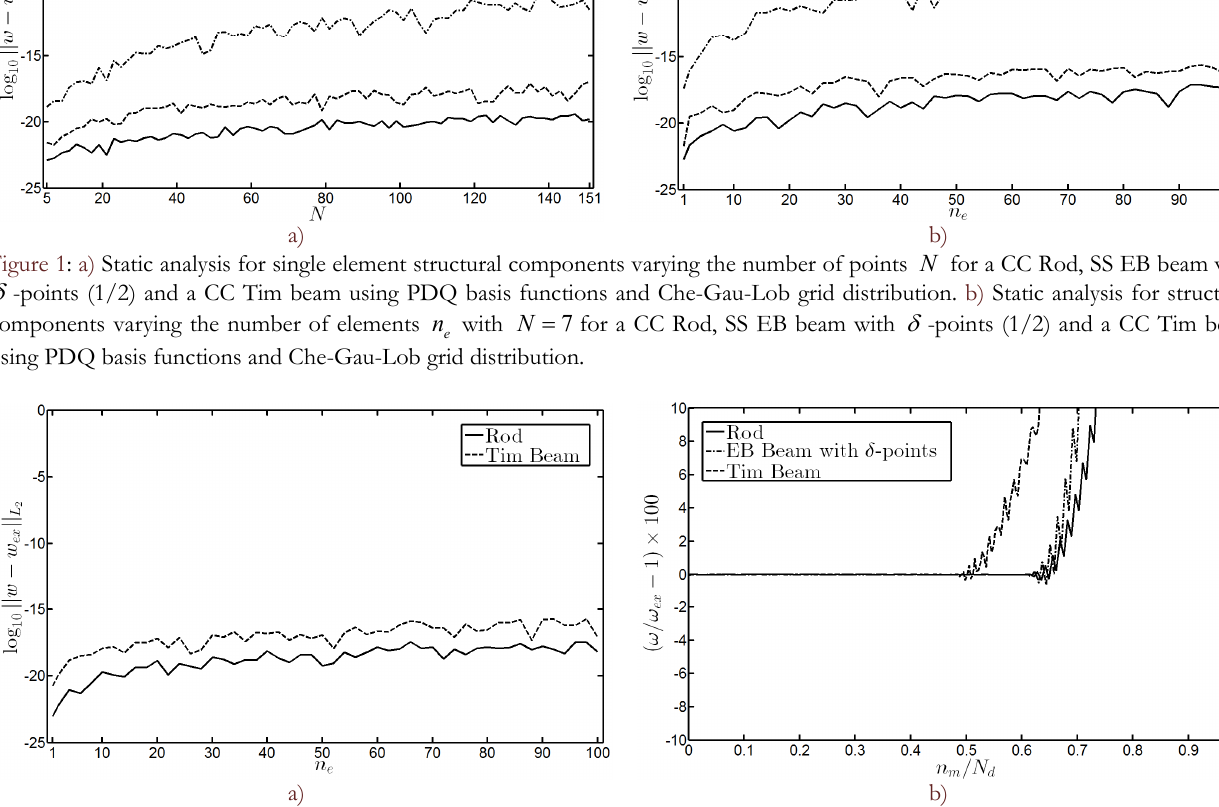
Figure 2: a) Static analysis for structural components using Weak Formulation (WFEM) varying the number of elements 7 N  for a CC Rod and a CC Tim beam using PDQ basis functions and Leg-Gau-Lob grid distribution. b) Dynamic discrete spectra for single element structural components with 151 N  for a CC Rod, a SS EB beam with  -points (1/2) and a CC Tim beam using PDQ basis functions and Che-Gau-Lob grid distribution.